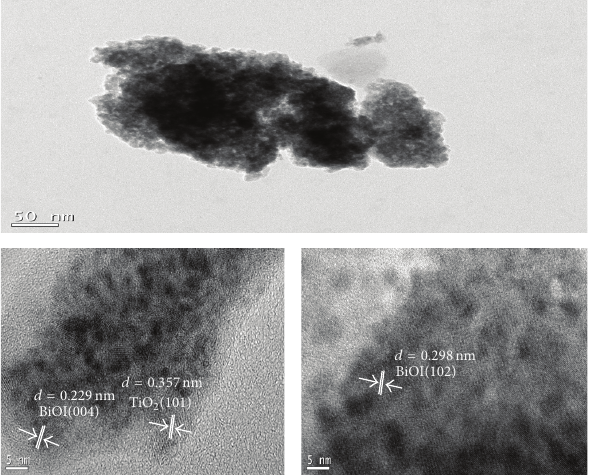
Figure 5: TEM image of 75% BiOI-TiO 2